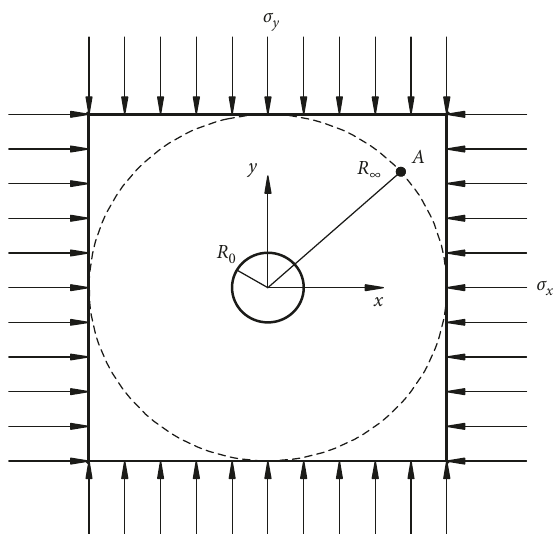
Figure 1: Force diagram of the surrounding rock wall of non- uniform